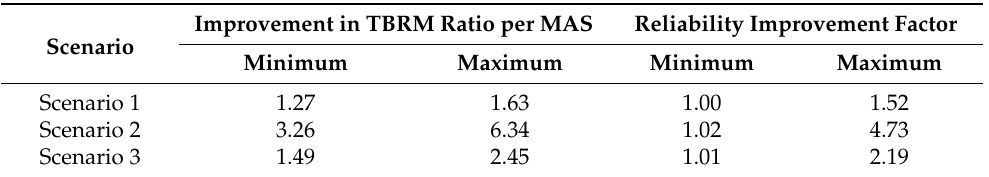
Table 10. Summary of improvement ratios for fault tolerance and reliability metrics used in the three studies, as compared with the benchmark/control group.